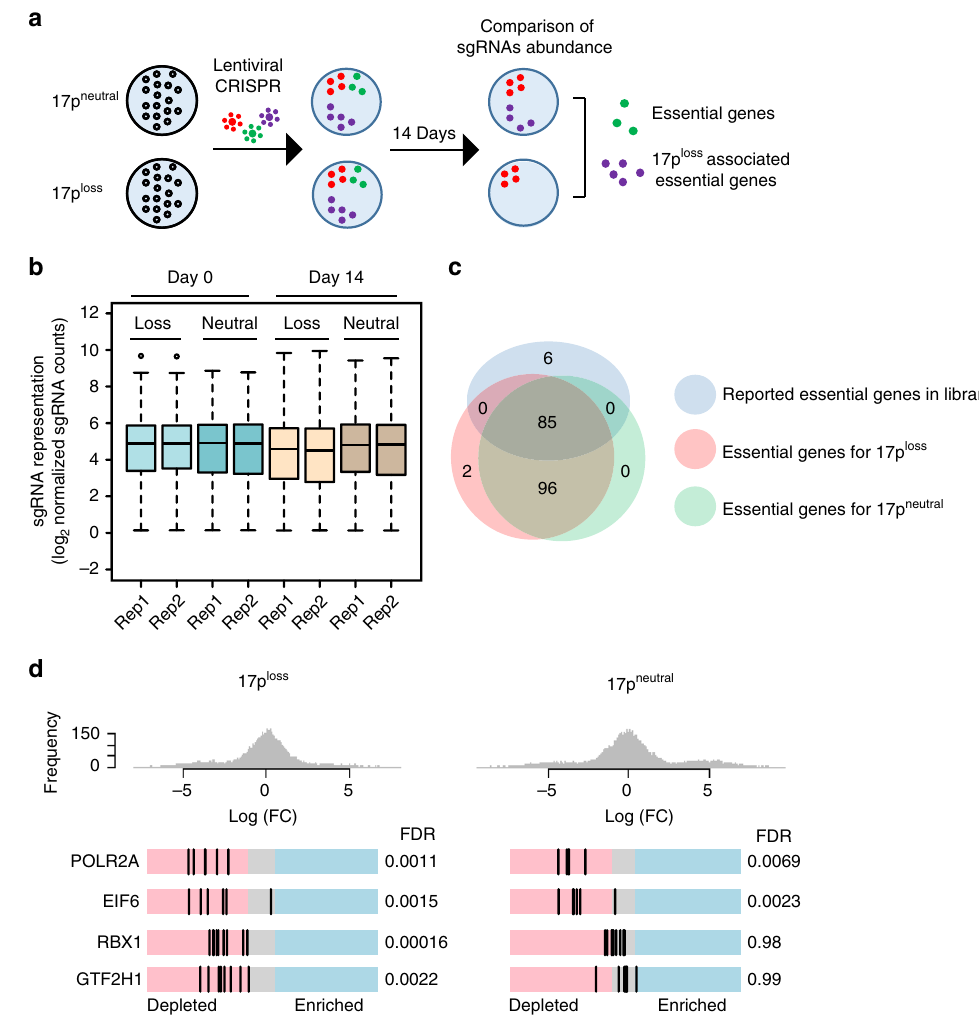
Fig. 2 CRISPR-Cas9 screen identi fi es RBX1 as an essential gene for 17p loss prostate cancer cells. a Schematic illustration of CRISPR screening procedure in the isogenic pair of DU145 cells. b Box plots showing the distribution of sgRNA frequencies at different time points. c Overlapping of essential genes from this screen and from the previous reports. d Frequency histograms of enriched or depleted sgRNAs. POLR2A and EIF6 are two representatives of common essential genes. RBX1 and GTF2H1 are representatives of selective essential genes in the context of 17p